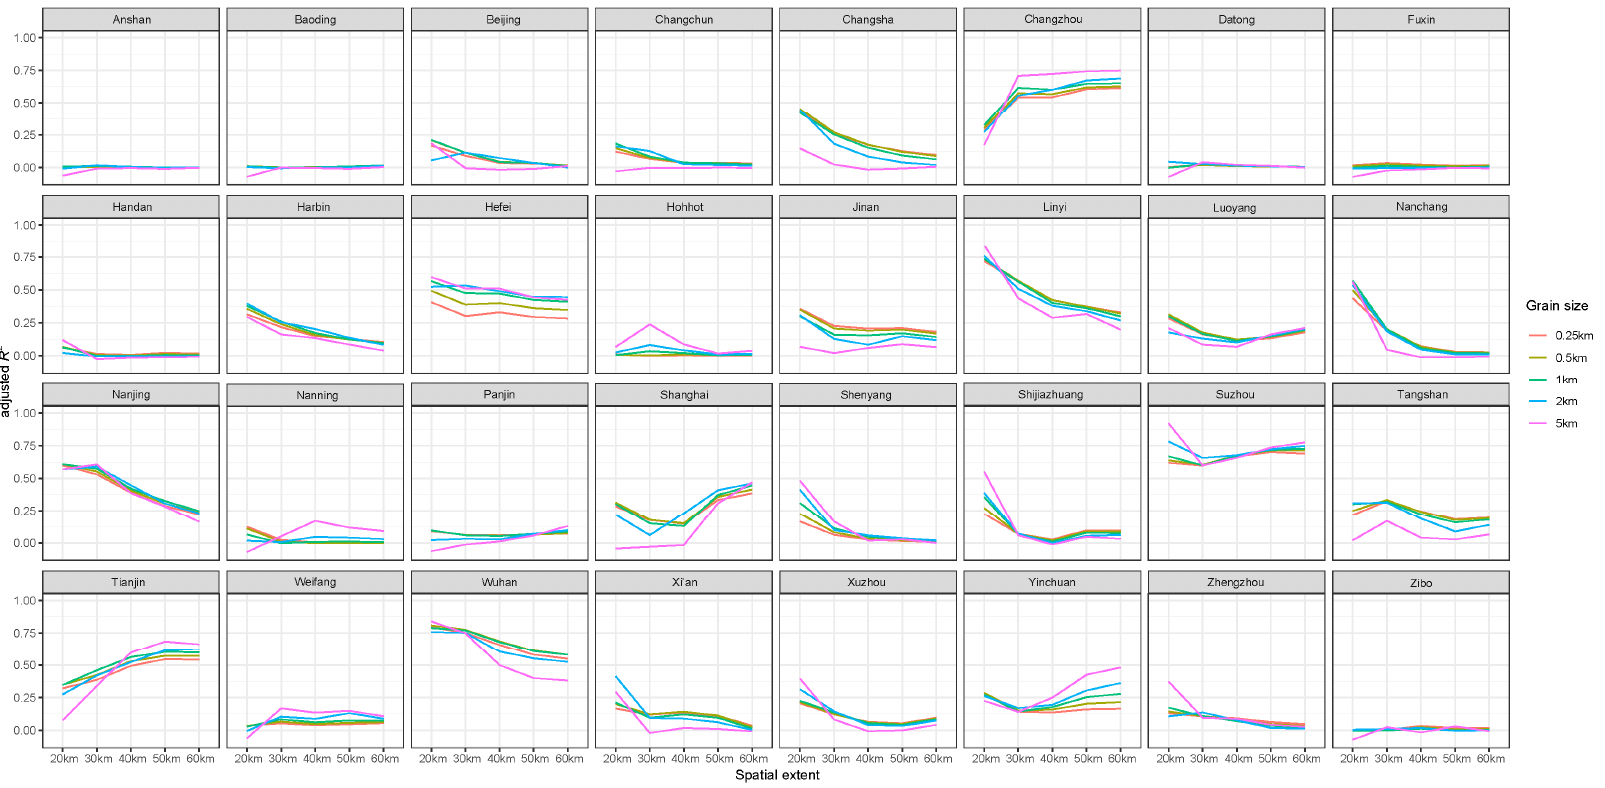
Figure A10. Explanatory power of WC for explaning LST(Scalogram of the spatial extent)